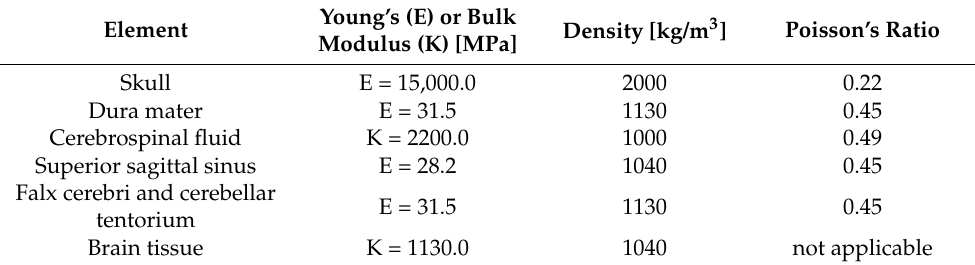
Figure 2. α HEAD model: ( a ) isometric view, ( b ) sagittal section view through the skull, ( c ) coronal section view through the skull. Table 1. Mechanical properties for each component of the head (presented in details in [66]).